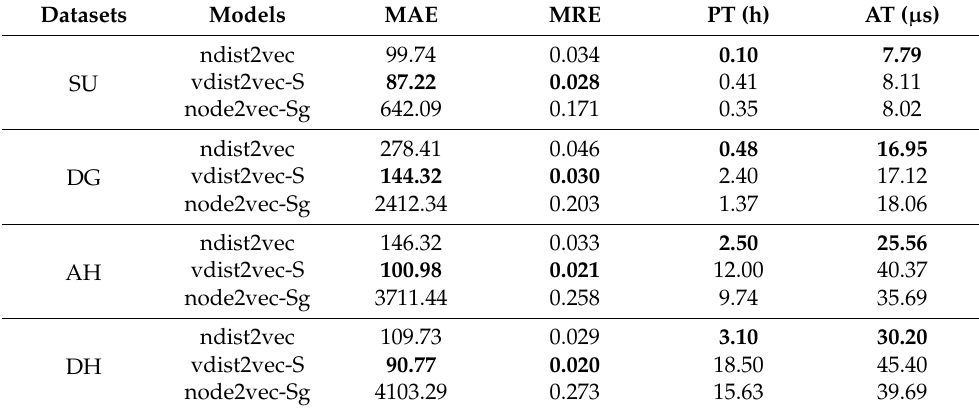
Table 2. Experimental results of three